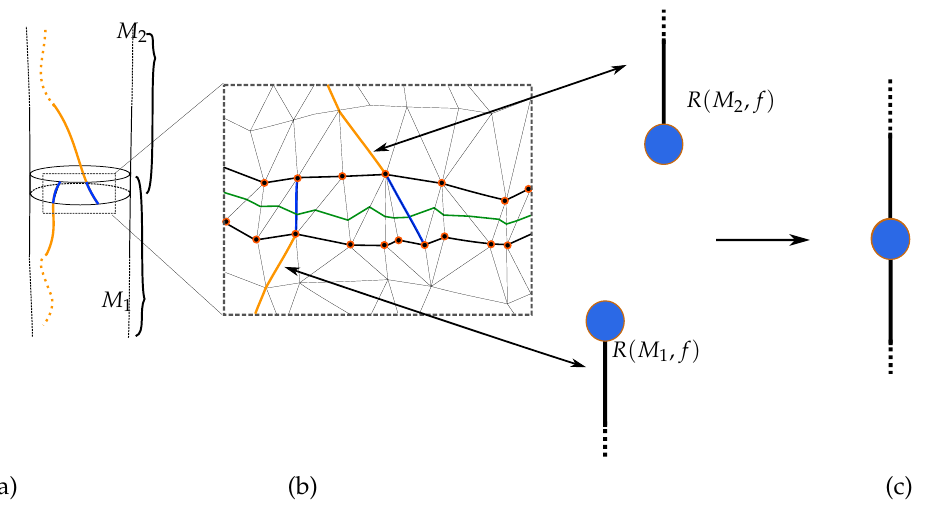
Figure 12. An illustration of the gluing stage. ( a ) At this stage, two ascending paths from all submanifolds have been calculated. In the case when two consecutive submanifolds share a crossing edge, such as the case in the illustrative figure, the ascending path of the lower submanifold M 1 gets terminated at the at a crossing edge. Similarly, an ascending path from the higher submanifold M 2 gets initiated at a crossing edge. ( b ) A zoomed version of Figure ( a ) shows the two crossing edges that determine uniquely two nodes in the Reeb graphs R ( M 1 , f ) and R ( M 2 , f ) . The fact that these two edges belong to the same connected component in the inverse image of the regular crossing value is used to glue the graphs R ( M 1 , f ) and R ( M 2 , f ) along the blue nodes to obtain the graph in Figure ( c